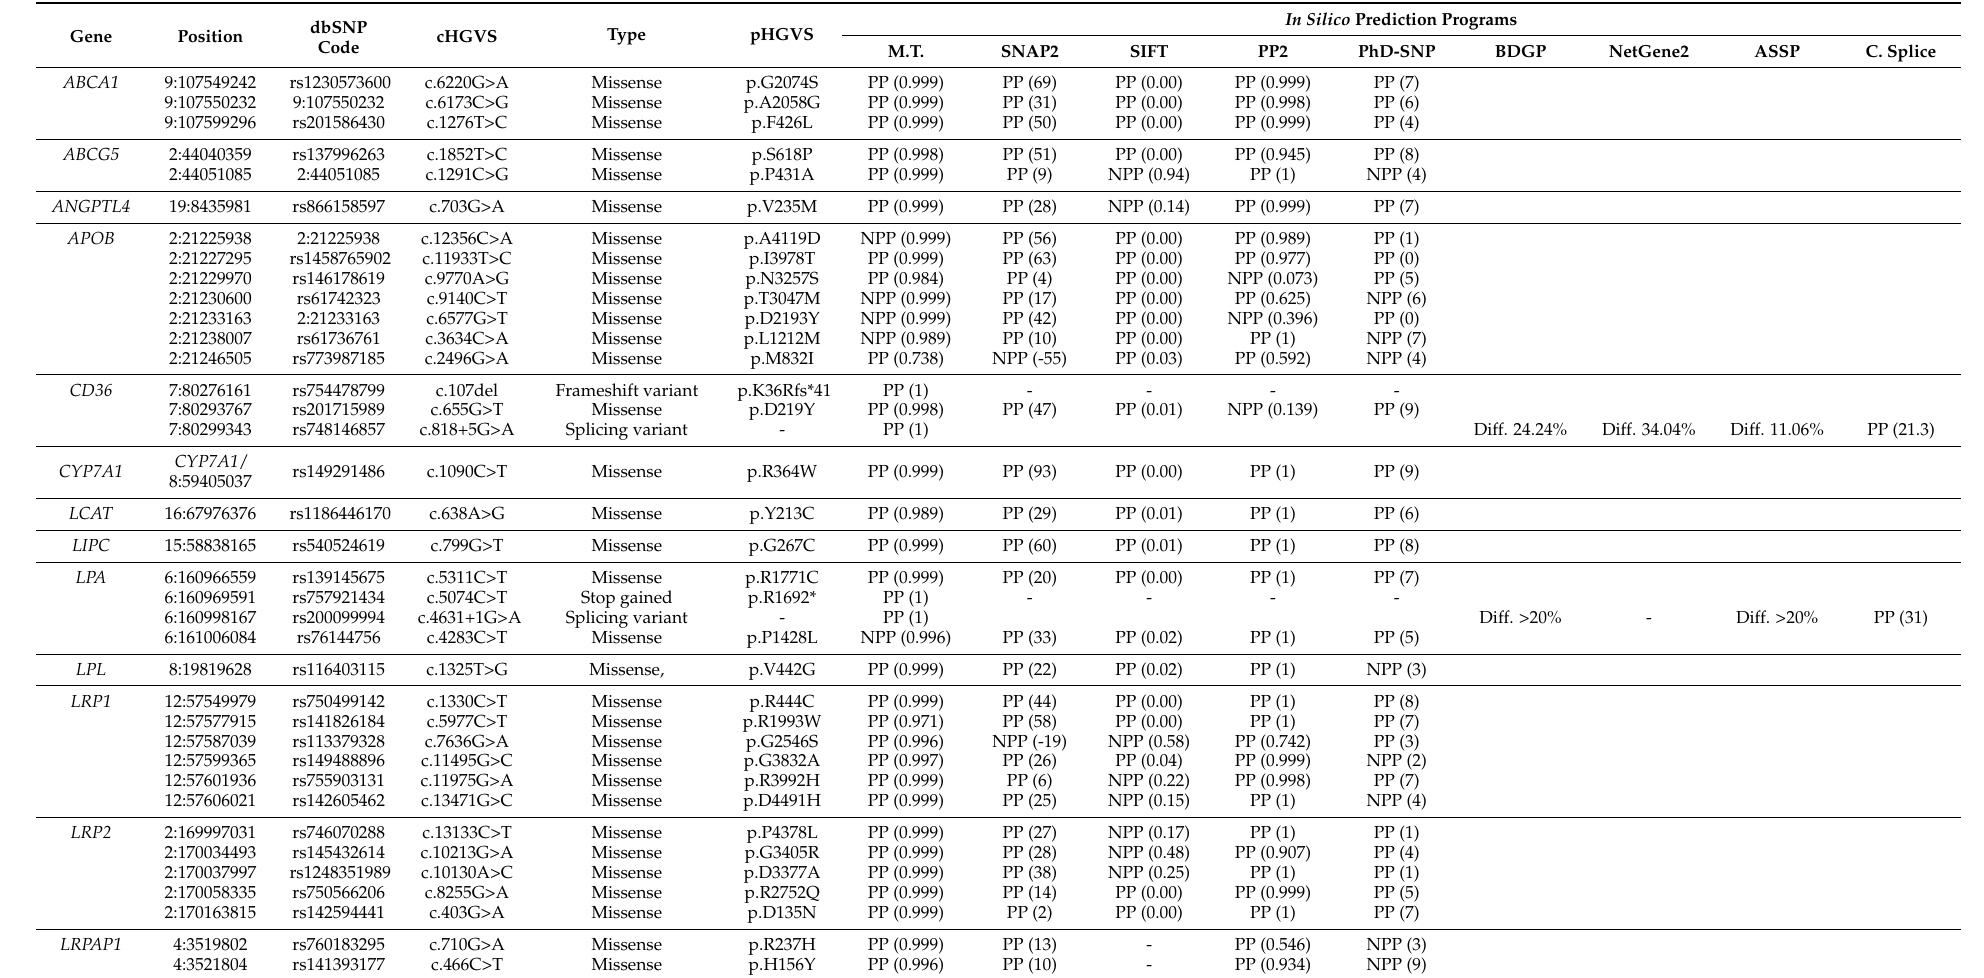
Table 3. Category IIp (potential